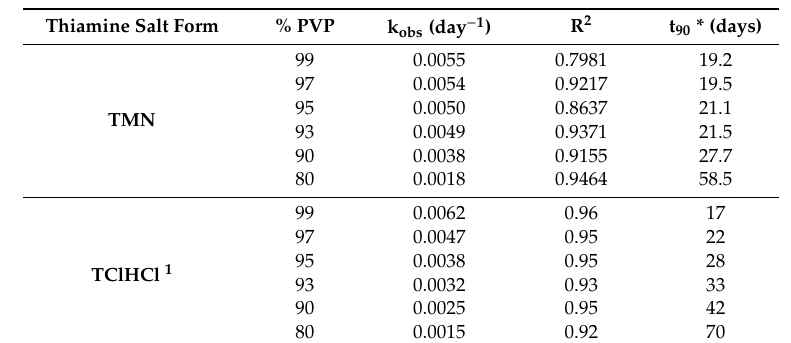
Table 2. Reaction rate constants and t 90 values for thiamine degradation in TMN and TClHCl solid dispersions prepared with di ff erent proportions of PVP when stored at 11% RH and 60 ◦